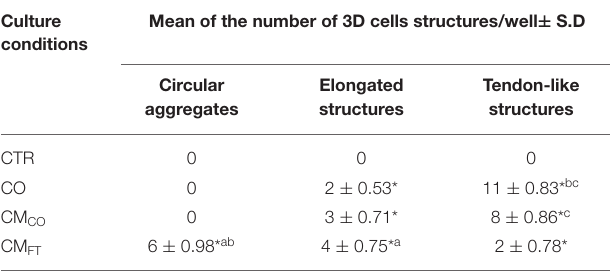
Numberof3Dcellsstructurescountedindifferentexperimentalconditionsandexpressed as the mean ± S.D obtained by analyzing 12 well/ experimental group for each animal (n = 6). Data were analyzed by One Way ANOVA Test followed by Tuckey post hoc